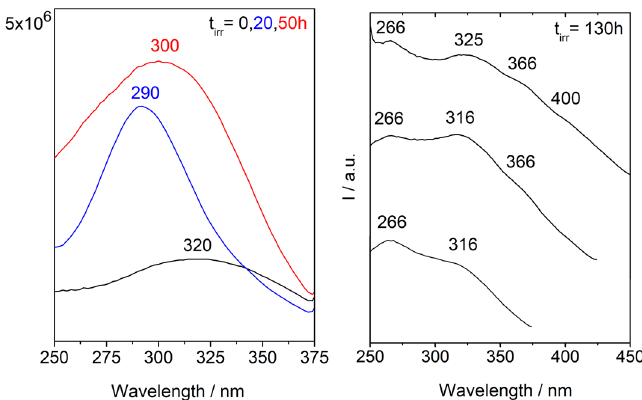
Figure 4. Irradiation of cellulose nitrate films followed by luminescence. Left, unreacted CN film is characterized by a broad excitation spectrum centred at 320 nm (λ em = 390 nm), and in the first 20 h of irradiation the maximum is shifted to shorter wavelengths (290 nm) and then evolve to a maximum at circa 300 nm at 50 h of irradiation, which will continue to shift to longer wavelengths. Right, excitation spectra at 130 h of irradiation several oxidized functions are observed described by maxima at 266, 325, 366 and 400 nm (λ em = 390, 450 and 480 nm). This agrees with the yellowing observed in the